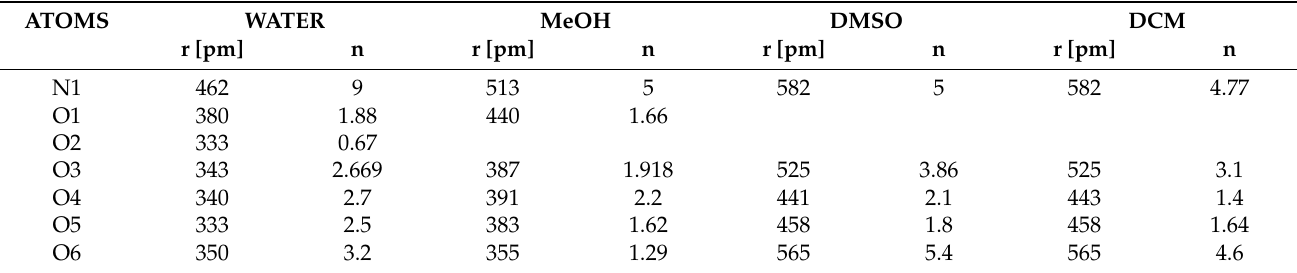
Table 1. Number of solvents around the first solvation shell of the selected sites of linamarin. The data were obtained from local density (distance and